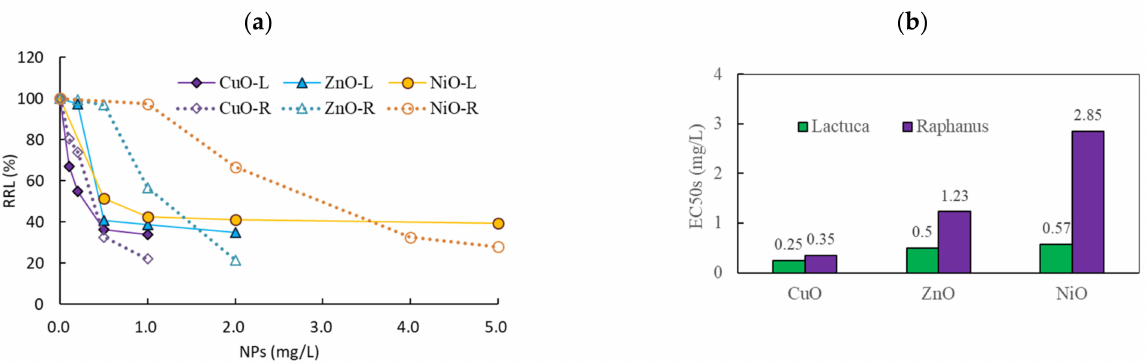
Figure 3. Effects of nanoparticle (NP) exposure on the root growth of Lactuca sativa and Raphanus sativus under shaking incubation conditions based on ( a ) relative root growth and ( b ) EC 50 . In ( a ), L and R represent L. sativa and R. sativus ,